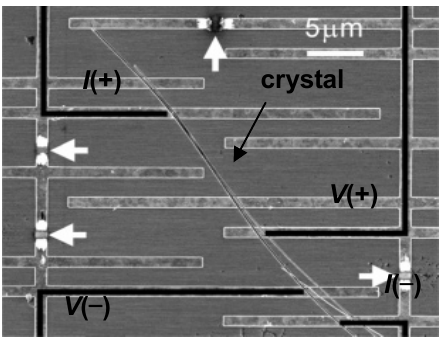
Figure 22. SEM image of four-probe circuit on a ( DMe–DCNQI ) 100 nm in width and thickness and 60 μ m in length. Electrodes were cut at the points indicated by white arrows. [Reproduced with permission from [19] J. Am. Chem. Soc . 2006